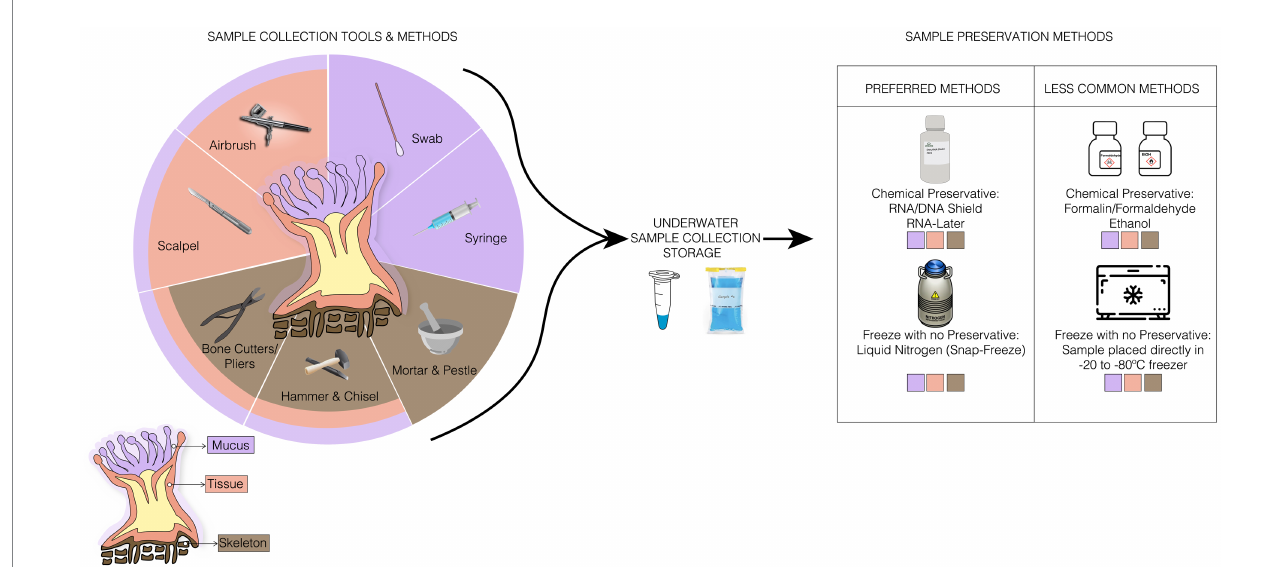
FIGURE 1 Illustration of ideal sampling strategies for each coral compartment, collection storage, and the preferred and less common sample preservation methods used for any coral samples. In samples collection methods, there are specific tools for a compartment of the coral, such as the syringe used only for the collection of mucus, and tools, such as the bone cutter, used to collect any sample from the